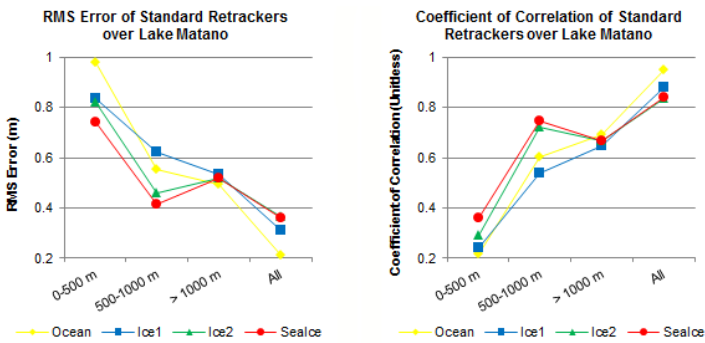
Figure 17. The performance of Envisat RA-2 radar altimetry measurements over Lake Matano, classified by the distance to the lakeshore.